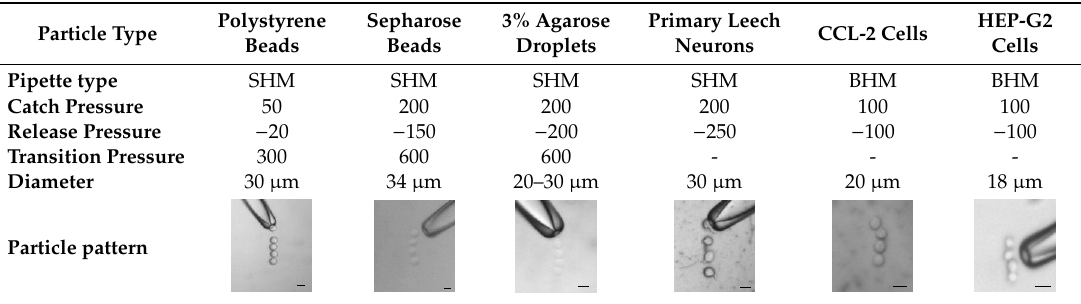
Table 1. Calibrated pressure values for all particles. Pressure values were measured by the rotation of the microinjectors fine knob in µ m units. Small holding micropipette (SHM) and baby holding micropipette (BHM) were used. Scale bars: 30 µ m.